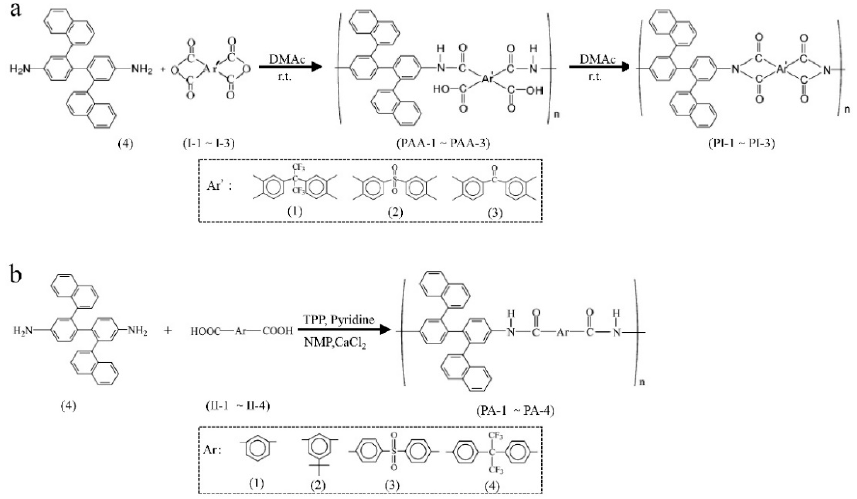
Figure 12. Synthesis of various polyimides ( a ) and polyamides ( b ). Adapted from Reference [82].